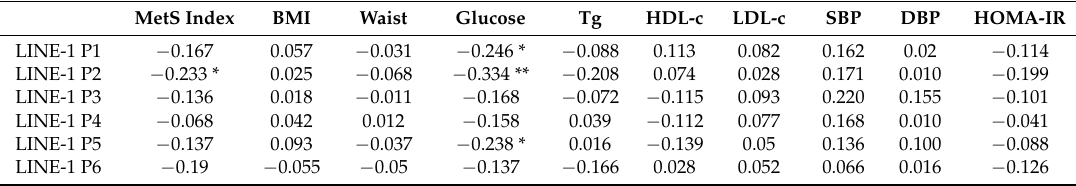
Table 3. Pearson’s correlation between LINE-1 CpG positions (P1, P2, P3, P4, P5, P6) and the anthropometric and biochemical variables related to MetS. * p < 0.05 and ** p < 0.01 were considered statistically significant.